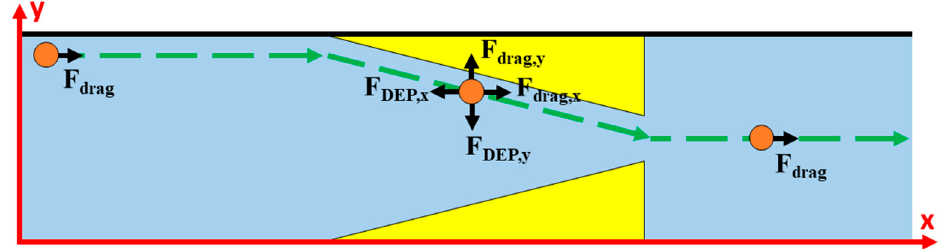
Figure 3. Schematic of the top-view of the trajectory of microparticle.